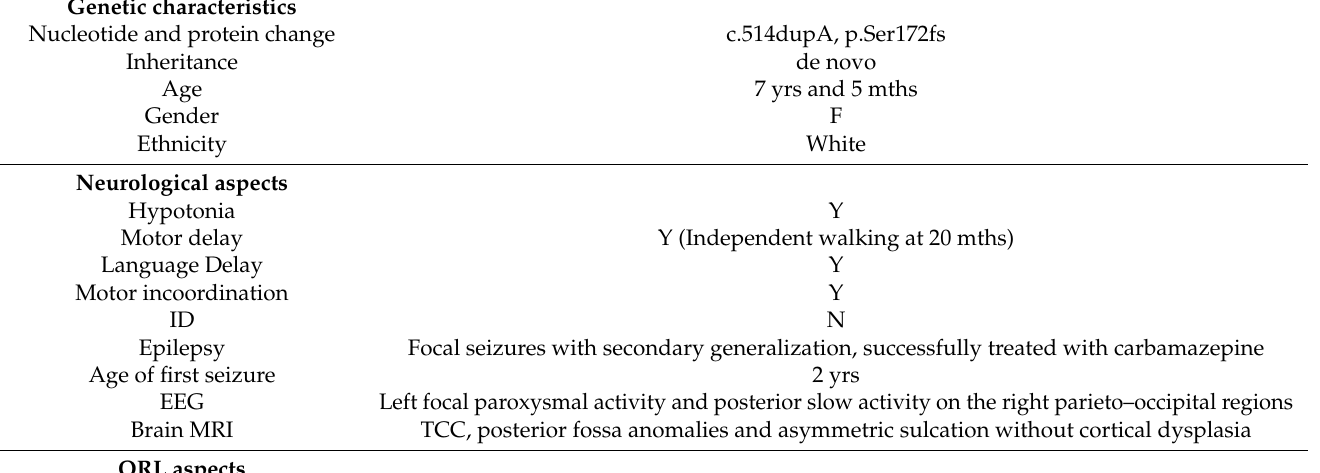
Table 1. Genetic, clinical, and neuroradiological characteristics of our proposita.